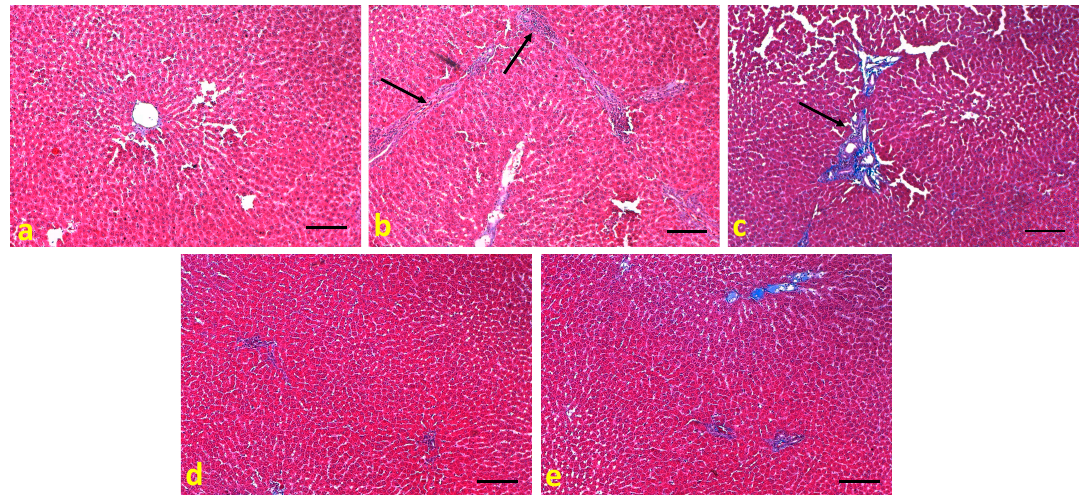
Figure 11. The collagen fiber was measured in all the experimental groups using Masson’s trichrome staining. ( a ) Collagen fiber not observed in normal hepatocytes; ( b , c ) the collagen fiber was significantly higher in STZ-induced rats; ( d ) The TQ treatment in diabetic animal group showed reduction of collagen. ( e ) PC group only showing very low collagen fiber deposition (Scale bar = 100 μ m).